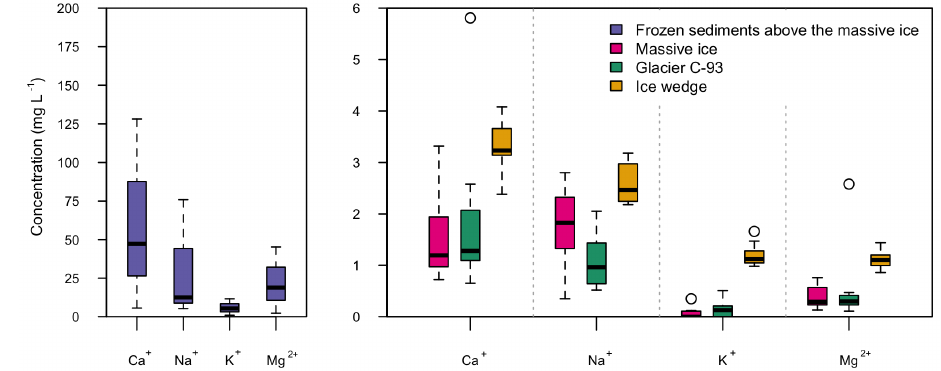
Figure 7. Box plots showing soluble cation concentration of the massive ice, ice wedge, glacier C-93 and intrasedimental ice sampled within the sediments layers covering the massive ice unit.